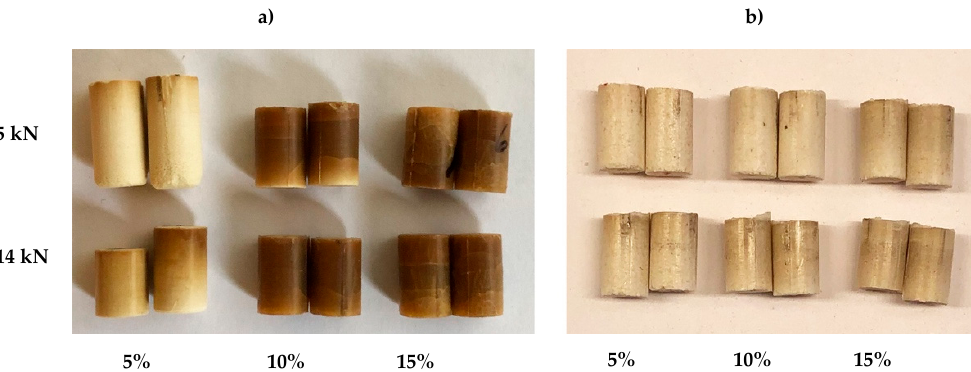
Figure 8. Picture of: ( a ) xylan pellets and ( b ) carboxymethyl cellulose (CMC) pellets. Pellets with a 5% moisture content to the left in the picture and pellets with a 15% moisture content to the right, with 10% moisture content pellets in the middle. The upper row are pellets pressed up to 5 kN and the lower row were pressed up to 14 kN.